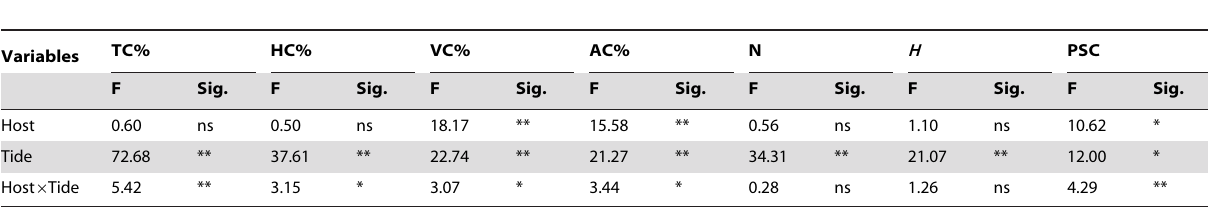
Table 3. Analysis of parameter estimates from generalized linear models (univariate and multivariate two-way ANOVA): effects of host, tide level and their interactions on AMF colonization intensity, phylotype richness, Shannon’s index and phylotype community structure within each root sample.